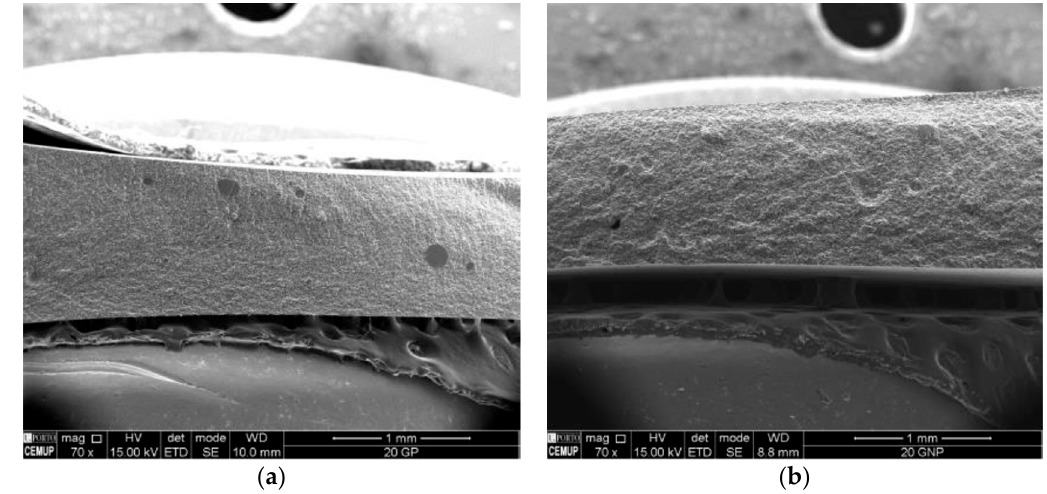
Figure 5. Scanning electron microscope (SEM) images (through thickness) of the samples. ( a ) Resin with 20% graphite powder (GP); ( b ) resin with 20% graphite nanoplatelets (GNP).